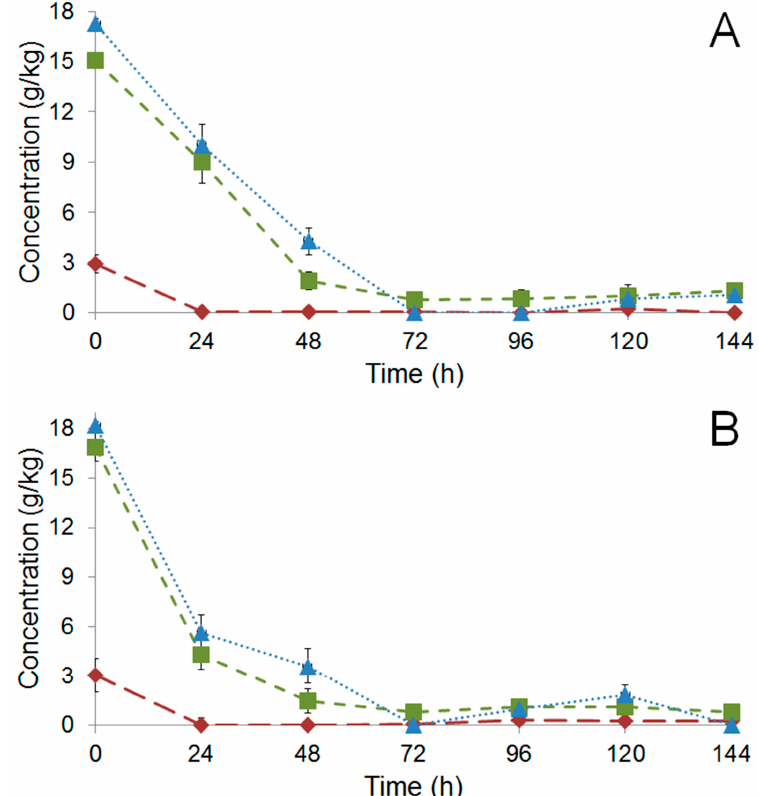
Figure 2. Course of glucose ( Figure 2. Course of glucose ( ), fructose ( ), and citric acid ( ) during fermentation of PH15 Figure 2. Course of glucose ( ), fructose ( ), and citric acid ( ) during fermentation of PH15 Figure 2. Course of glucose ( ), fructose ( ), and citric acid ( ) during fermentation of PH15 Figure 2. Course of glucose ( ), fructose ( ), and citric acid ( ) during fermentation of PH15 NI ( A ) and PH15 I ( B ). NI ( A ) and PH15 I ( B NI ( A ) and PH15 I ( B ). NI ( A ) and PH15 I ( B ).